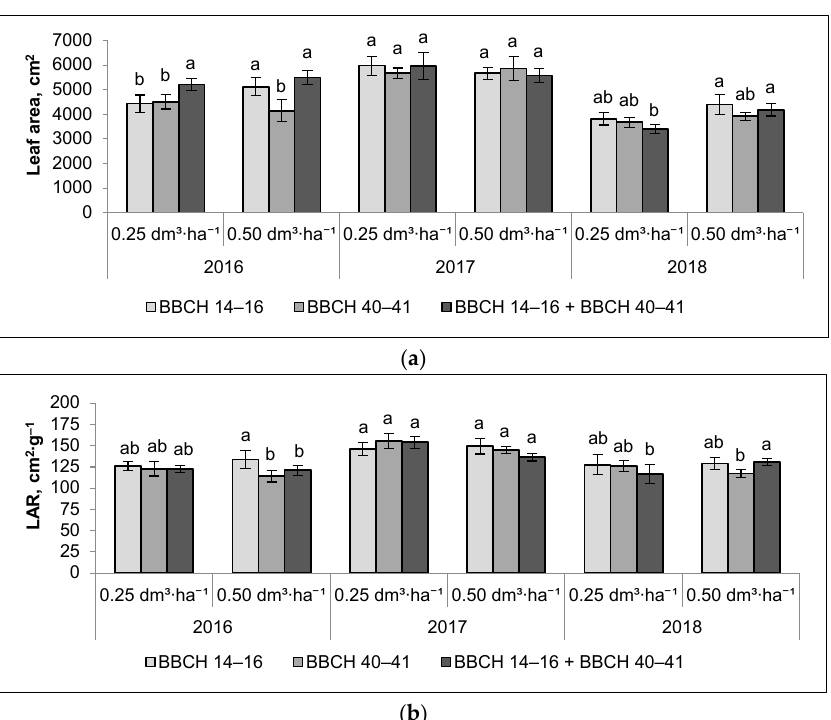
Figure 1. Leaf area ( a ) and leaf area ratio (LAR) ( b ) in relation to year, dosage and time of Optysil application. Time of Optysil application: leaf development stage, BBCH 14–16; tuber initiation stage,